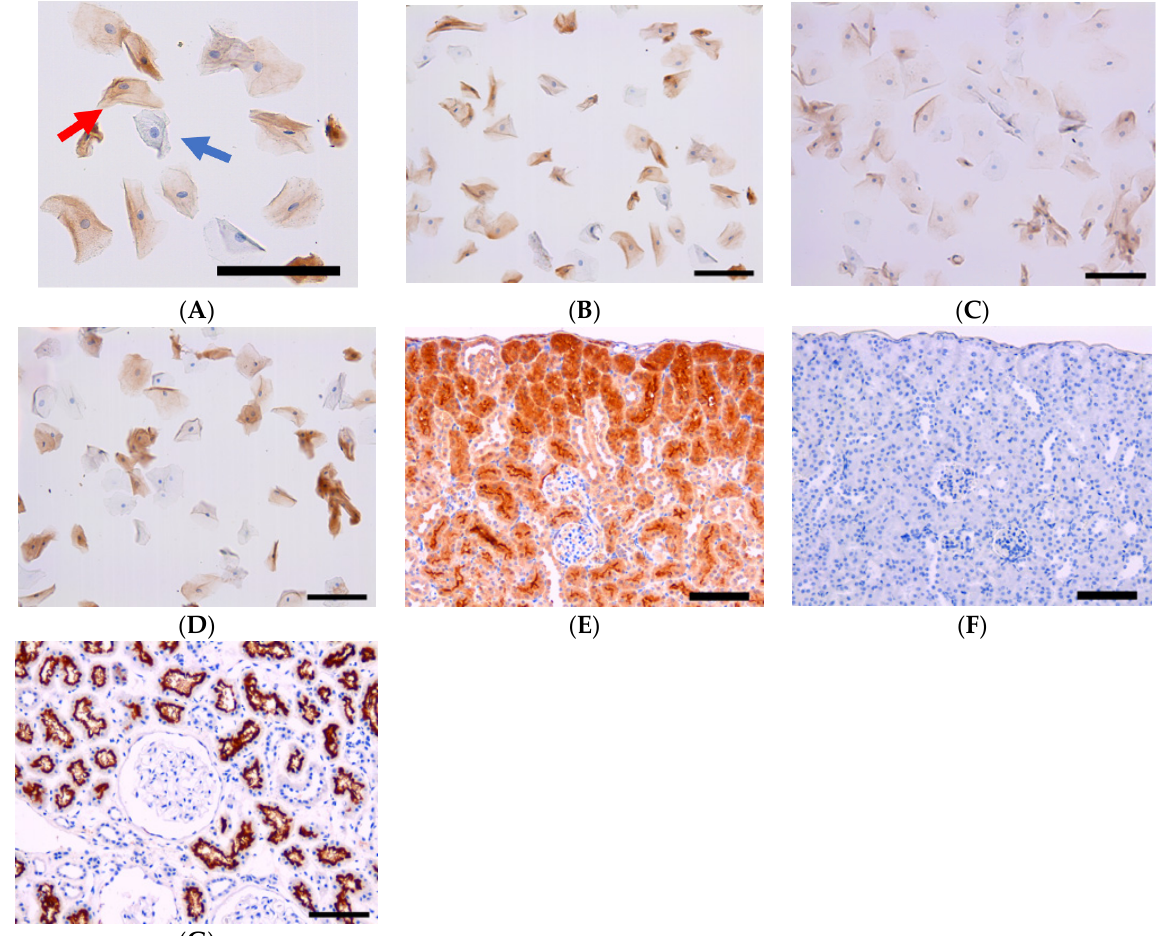
Figure 1. ( A ) Typical case of ACE2-positive and -negative cells. Blue arrow: ACE2-negative cell. Red arrow: ACE2-positive cell. Bar =100 μ m. ( B ) Representative ACE2 expression in tongue cells (bar = 100 μ m). ( C ) Representative ACE2 expression in palate cells (bar = 100 μ m). ( D ) Representative ACE2 expression in gingival sulcus cells (bar = 100 μ m). ( E ) Positive control using mouse kidney. (bar = 100 μ m). ( F ) Negative control using mouse kidney without the 1st antibody (bar = 100 μ m). ( G ) Positive control using human kidney sample (bar = 100 μ m).